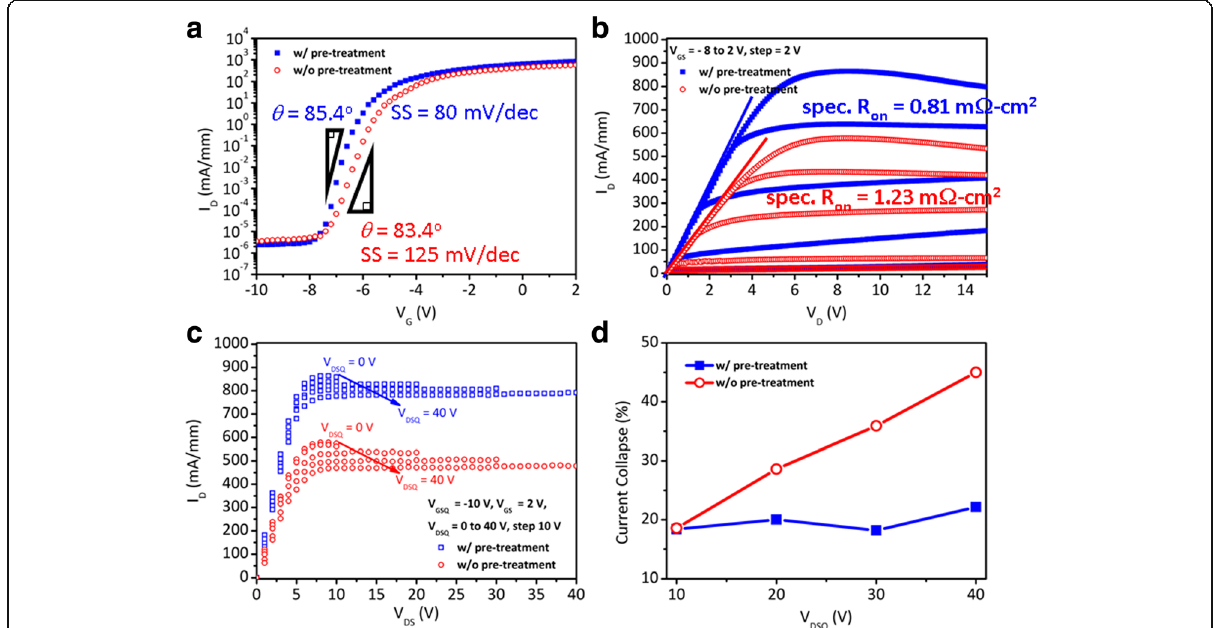
Fig. 3 a I DS - V GS characteristics of the ALD-AlN passivated HEMT with ( blue squares ) and without ( red circles ) plasma pre-treatment ( V DS = 10 V). b I DS - V DS characteristics of ALD-AlN passivated HEMT ( V GS from -8 to 2 V with 2 V step). c Pulsed I DS - V DS characteristic of HEMT with ( blue squares ) and without ( red circles ) plasma pre-treatment, V GSQ at -10 V, V DSQ sweep from 0 V to 40 V. d Current collapse (%) versus quiescent drain bias ( V DSQ